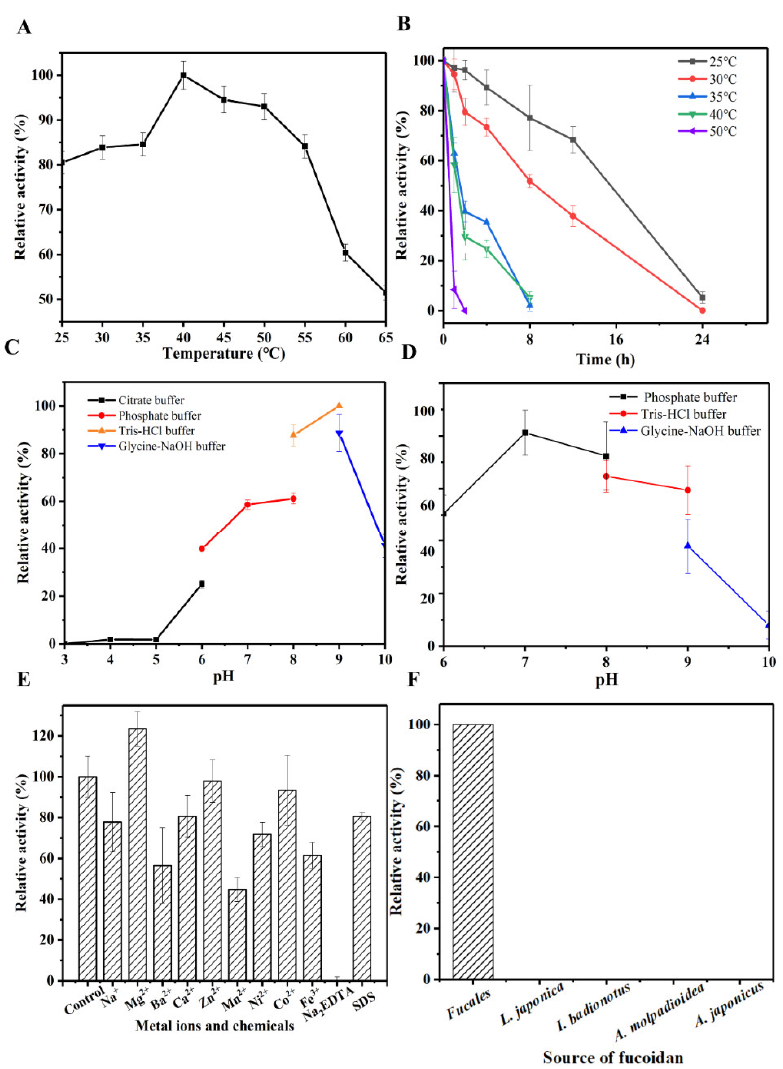
Figure 3. Biochemical characteristics of the purified OUC-FaFcn1. ( A ) Optimum reaction temperature. ( B ) Thermal stability of OUC-FaFcn1. ( C ) Optimum reaction pH. ( D ) pH stability of OUC-FaFcn1. ( E ) Effects of metal ions and chemicals. ( F ) Substrate specificity of OUC-FaFcn1.